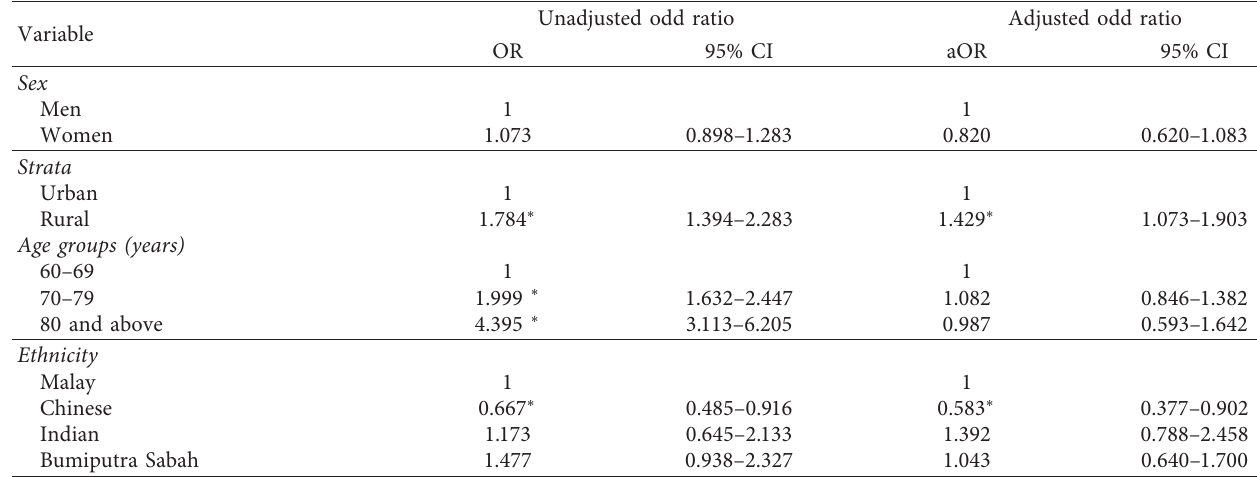
Table 3: Associated factor to at-risk or malnutrition among the elderly in